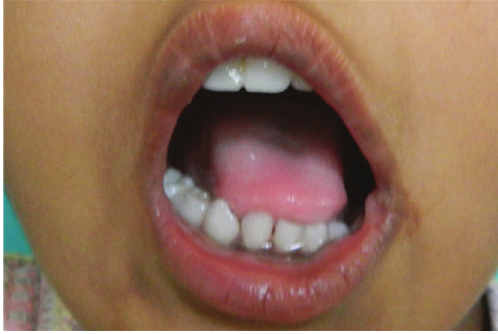
Figure 8: Adequate mouth opening